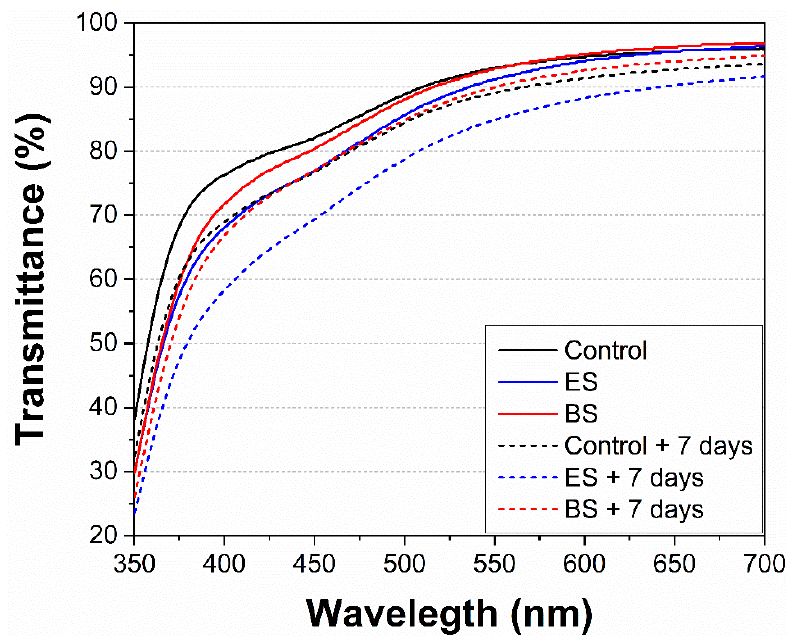
Figure 3. Comparison of the juice transmittance in the visible region immediately and 7 days post plasma exposure (+ 7 days) in the electrospray system (ES) and the batch system (BS).